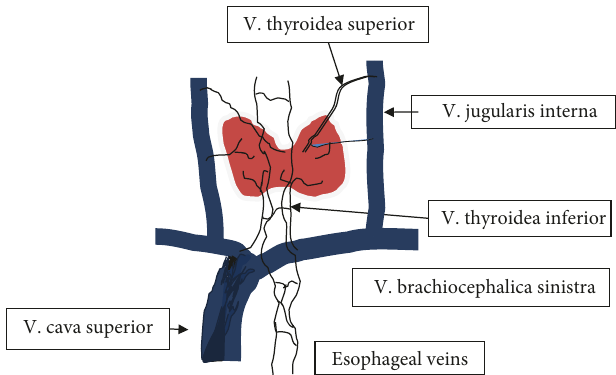
Figure 4: Schematic drawing of the collateral blood fl ow in the case of an occlusion of the vena cava superior. As shown, blood fl ows over the thyroid veins, then over the downhill varices of the esophagus and the azygos/hemiazygos vein into the inferior vena cava. Table 2: Reported reasons for downhill varices (summary). Superior vena cava